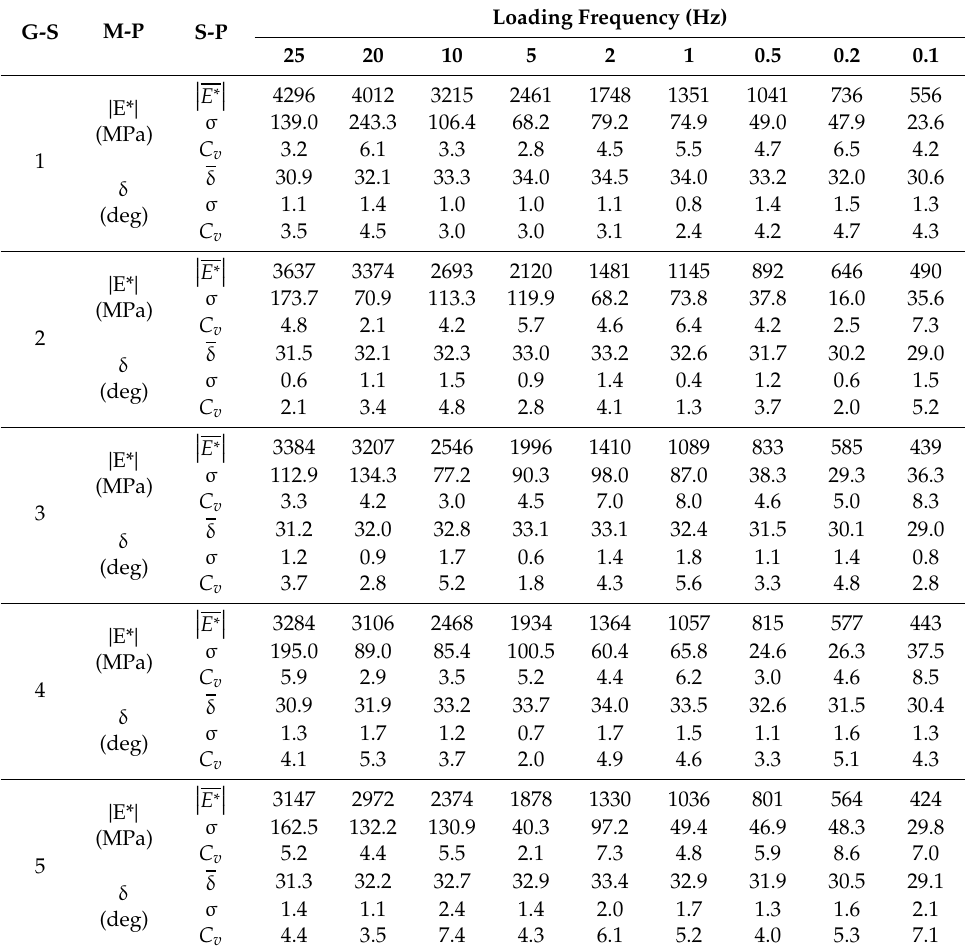
Table 5. The test results of the dynamic modulus and phase angle at 35 ◦ C.